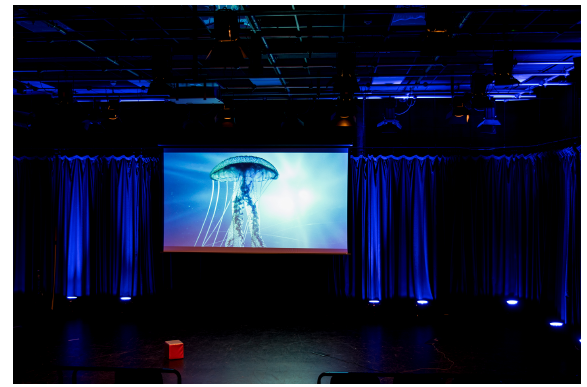
Figure 2. Underwater themed environment with